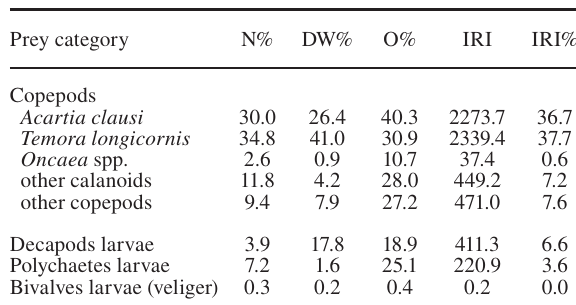
Table 2. – Diet composition of A. minuta from the northwestern adriatic sea. n%, numerical percentage; DW%, weight percentage; o%, frequency of occurrence; iri, index of relative importance; iri%, iri percentage